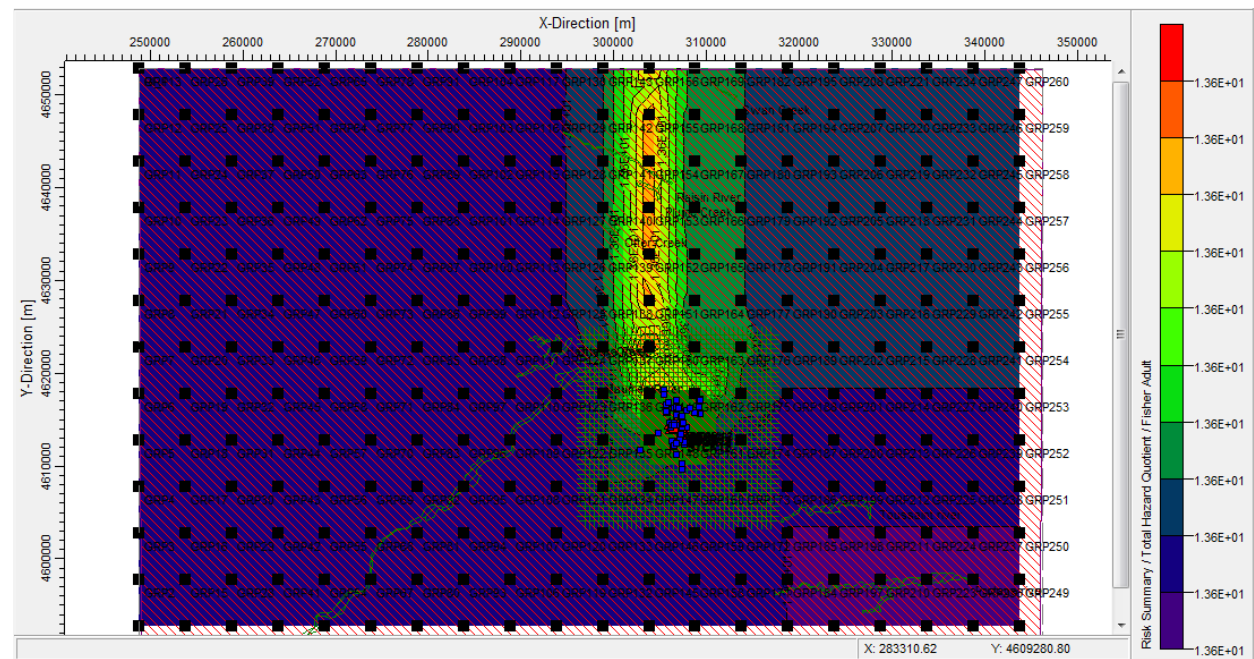
Figure 6. Contour plot of the total hazard quotient for location 3.